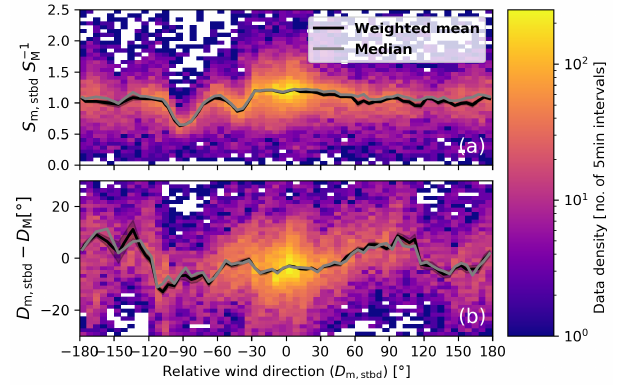
Figure 4. (a) Ratio of the relative wind speed recorded by the starboard and port anemometers ( S m , stbd S − 1 m , port ) as a function of the relative wind direction recorded by the starboard anemome- ter. (b) The difference in the relative wind directions recorded by the starboard and portside anemometers ( D m , stbd − D m , port ). The points denote 5min average values, and the colours denote the vari- ability of the 1min average wind direction within each 5min inter- val (the maximum of the variability of D m , stbd and D m , port ). The red line and shaded area show the respective average and standard error of the mean for the wind direction bins described in Sect. 3.4. The standard error of the mean was estimated via bootstrapping, and it amounts to ∼ 2% for the relative wind speed ratio and ∼ 0 . 2 ◦ for the relative wind direction difference. (A total of 0.8% of the data reside outside the plotted range, and for 4% of the data the wind direction variability is larger then 60 ◦ .)